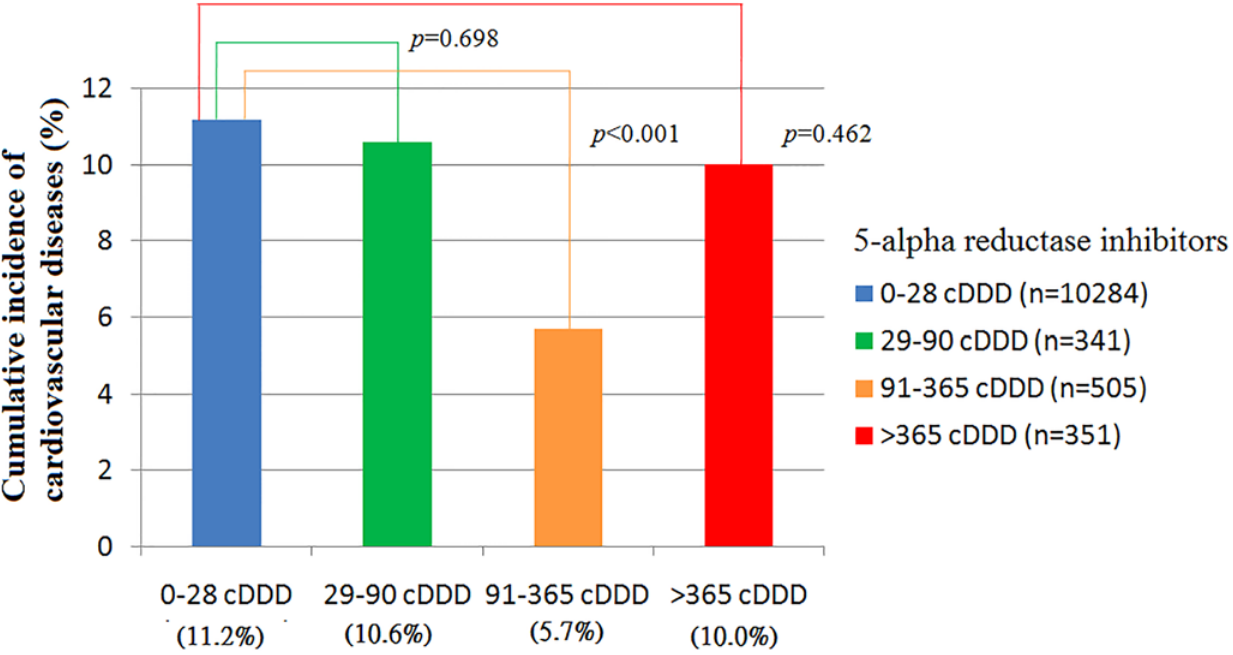
Fig 1. The 5-year Cumulative incidence of cardiovascular diseases in those receiving and not receiving 5-alpha reductase inhibitors.